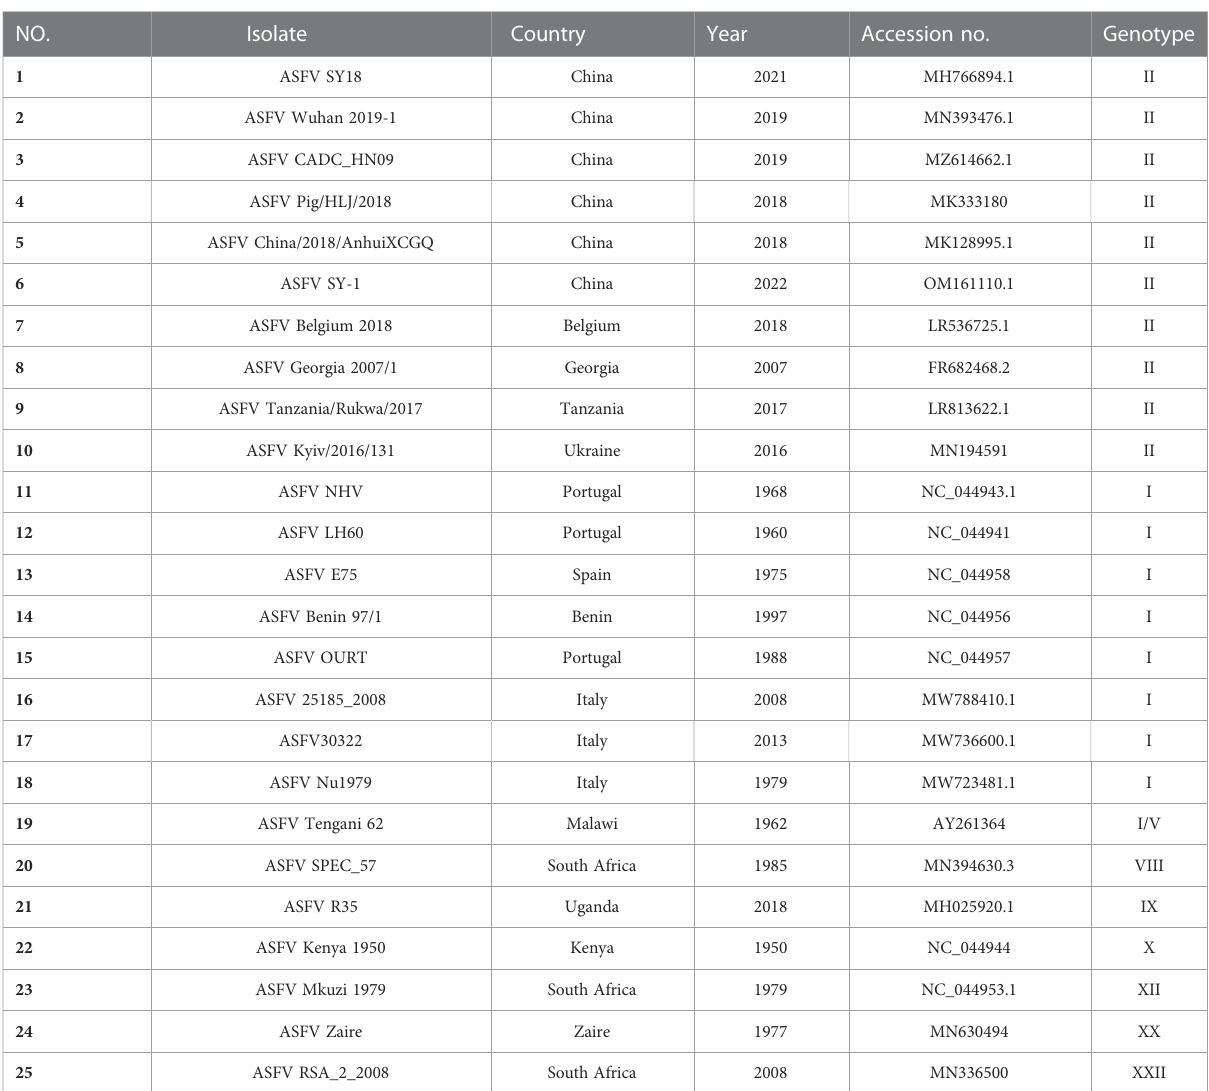
TABLE 3 Reference strains in this